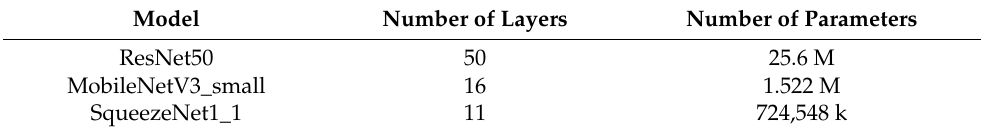
Table 1. Architectures and parameters of Resnet50 [41]; MobileNetV3_small [42]; and SqueezeNet1_1 [43].